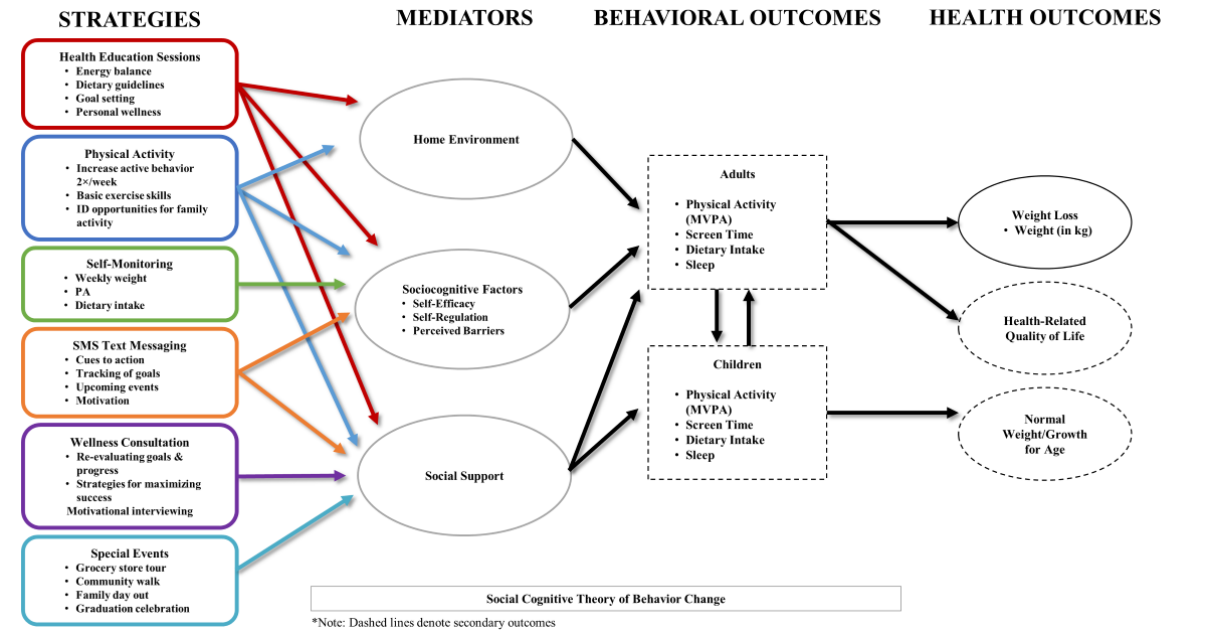
Figure 2. Healthy Frio remote technology intervention conceptual model. MVPA: moderate to vigorous physical activity; PA: physical